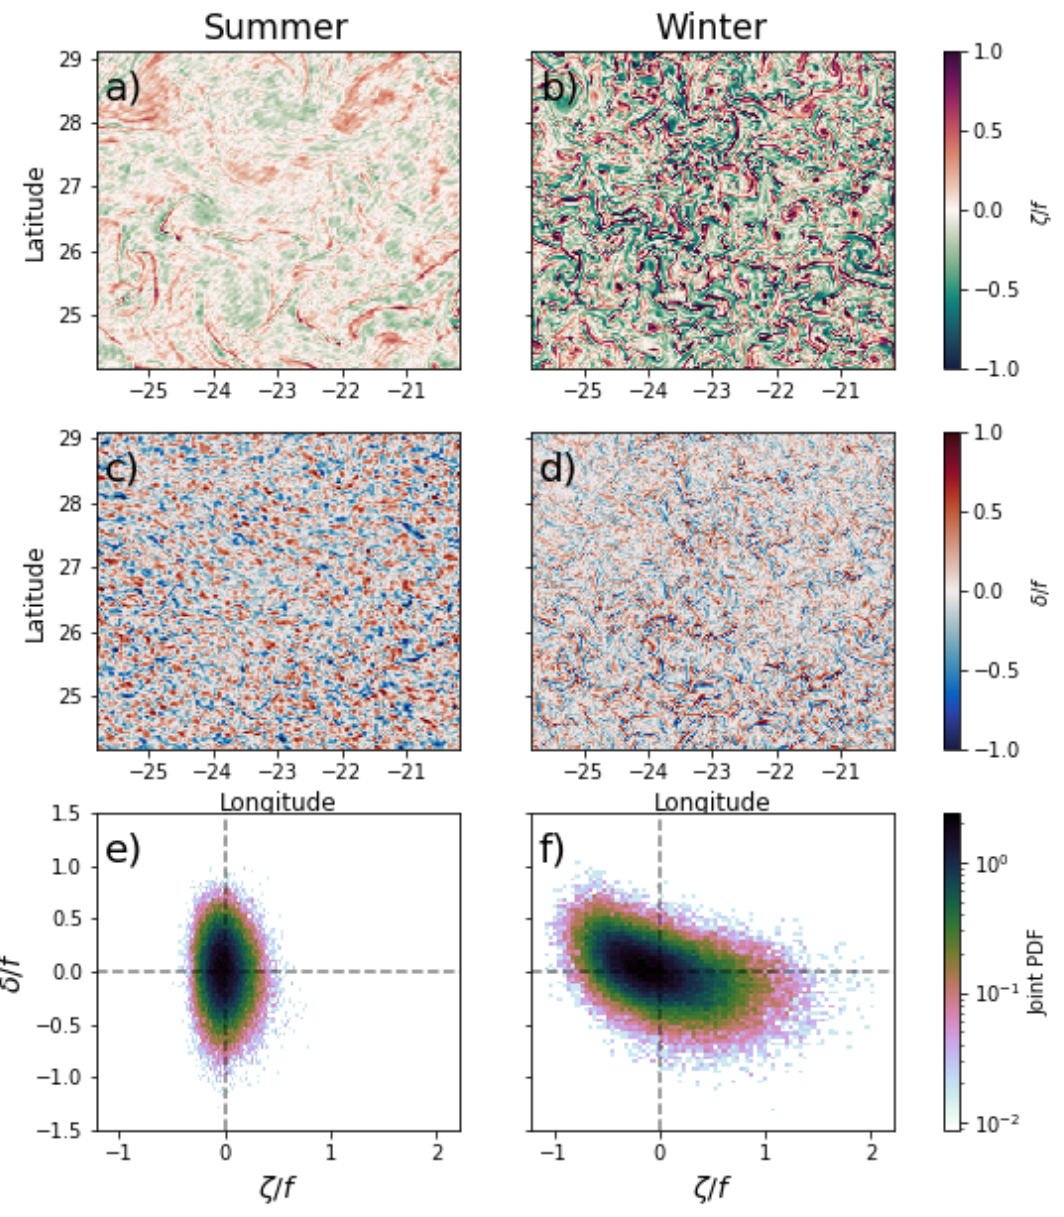
Figure 4. Snapshots of the total (unfiltered normalized) relative vorticity ( ζ / f : ( a , b )) and divergence ( δ / f : ( c , d )) fields, along with their corresponding ζ - δ joint probability distributions ( e , f ) at Canary (26.64 N) for summer ( a , c , e ) and winter ( b , d , f ) at times when the sea surface temperature was maximal (at around 5:00 p.m. local time). ζ and δ were then normalized by their Coriolis frequencies f . Joint PDF colors are presented on a logarithmic